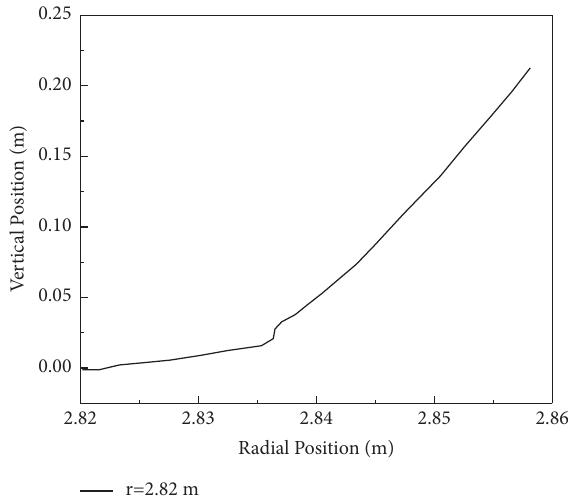
Figure 19: The trajectory of particle at 2.82m from the centre of rammer.